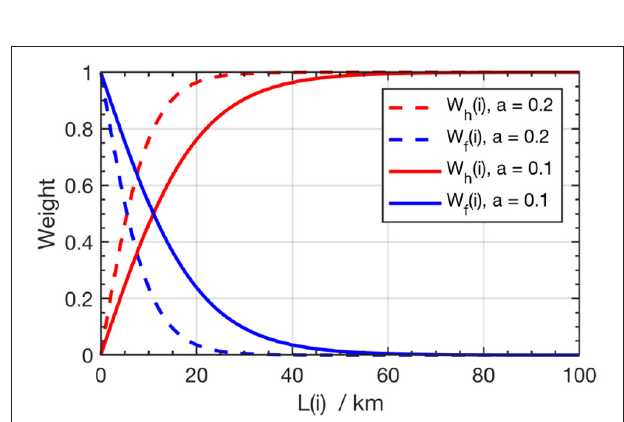
FIGURE 2 | Weight changes over the Euclidean distance at different values of a . When a = 0.2 is tuned for 24-h forecast, as W f ( i ) will approach a = 0 at